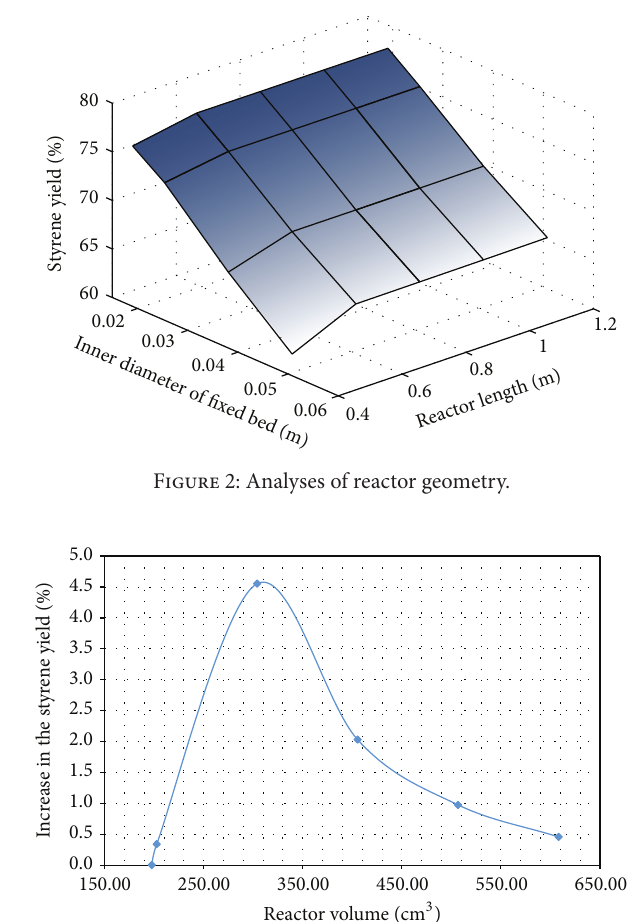
Figure 3: Influence of reactor volume on styrene yield at a constant mass